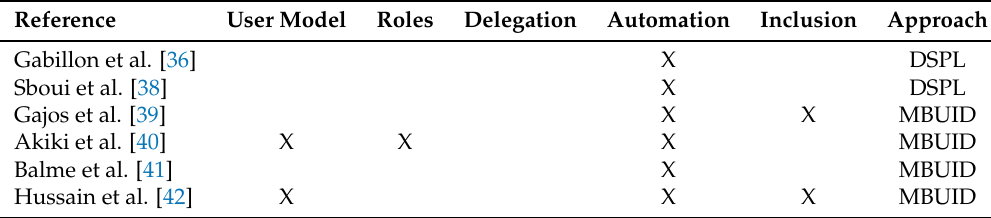
Table 1. AdUI approaches